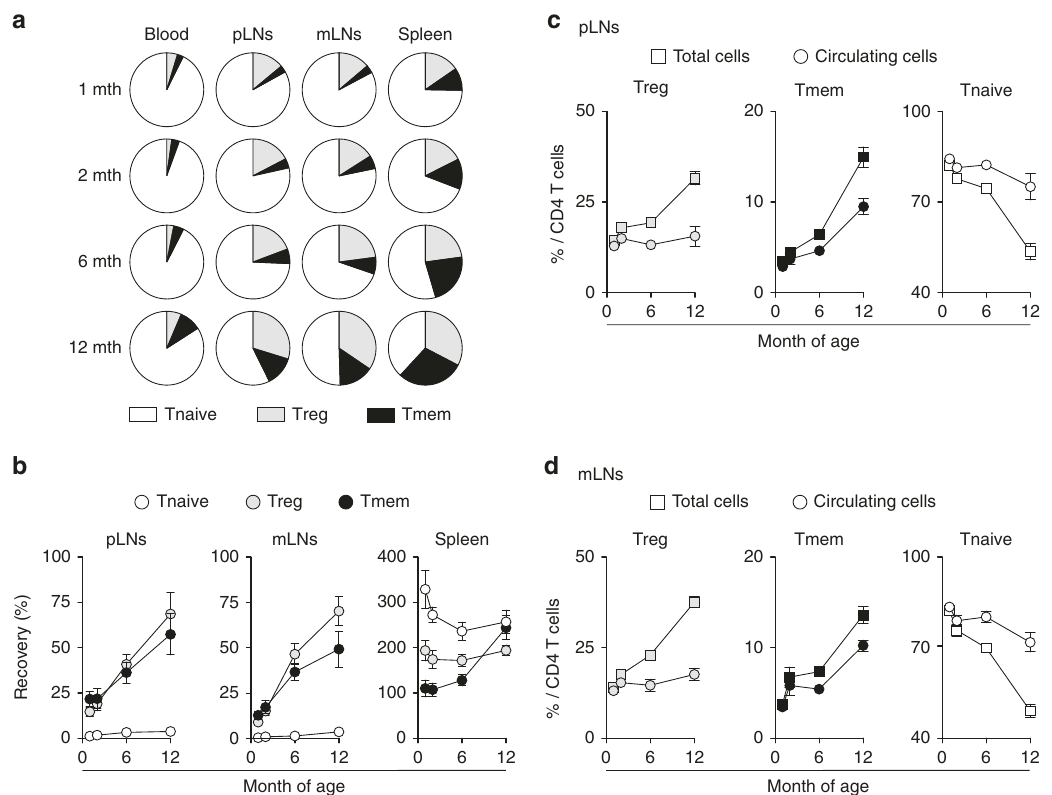
Fig. 3 T cell residence in SLOs increases with age in SPF mice. a Distribution of Treg, Tmem, and Tnaive cells among CD4 T cells in blood, pLNs (pooled super fi cial cervical, axillary, brachial, and inguinal LNs), mLNs, and spleen of 1 – 12-month-old C57BL/6 Foxp3-GFP mice. b C57BL/6 Foxp3-GFP mice of various ages were injected or not i.p. with 200 μ g of anti-LFA-1 ( α L) and anti-VLA-4 ( α 4) Abs. Forty-eight hours later, blood, pLNs, mLNs, and spleen were harvested and analyzed. Relative absolute numbers (recovery) of CD4 Treg, Tmem, and Tnaive cells in the indicated SLOs are shown as means ± SEM as a function of mouse age. c , d Percentages of Treg, Tmem, and Tnaive cells among total or “ circulating ” CD4 T cells are shown as means ± SEM for the indicated SLOs (see the experimental procedures for